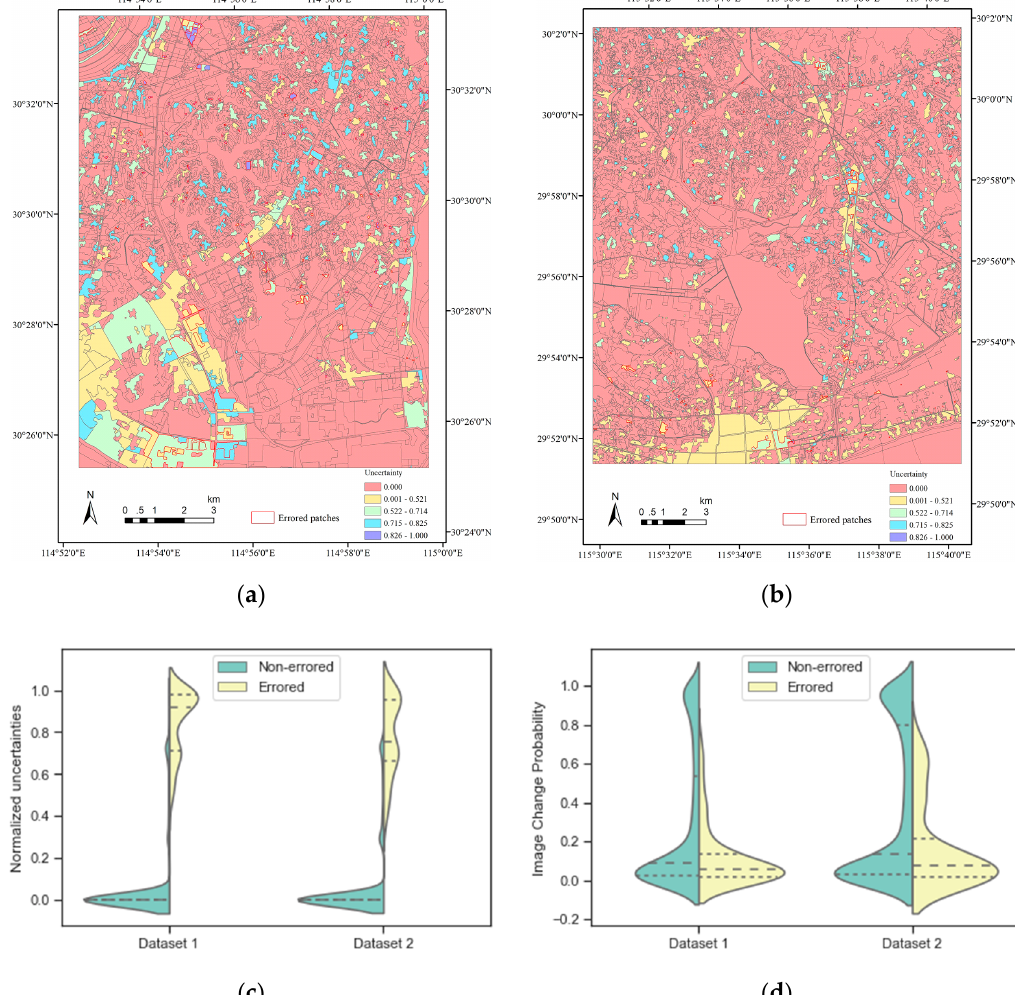
Figure 7. Spatial distribution of the final uncertainty in ( a ) Dataset 1 and ( b ) Dataset 2, and violin plots of errored and non-errored patches in Datasets 1 and 2 showing ( c ) patch label uncertainty and ( d ) image change probability.